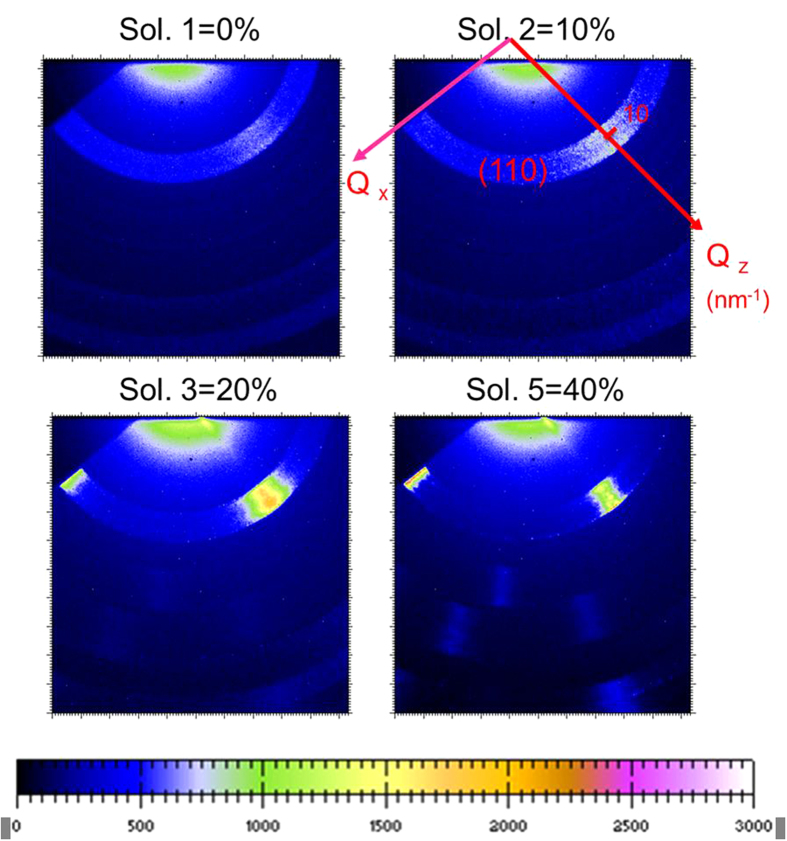
Two dimensional GIWAXS patterns of the one-step solution-processed CH3NH3PbI3−xClx films prepared with 0, 10, 20 and 40% of chloride, respectively.